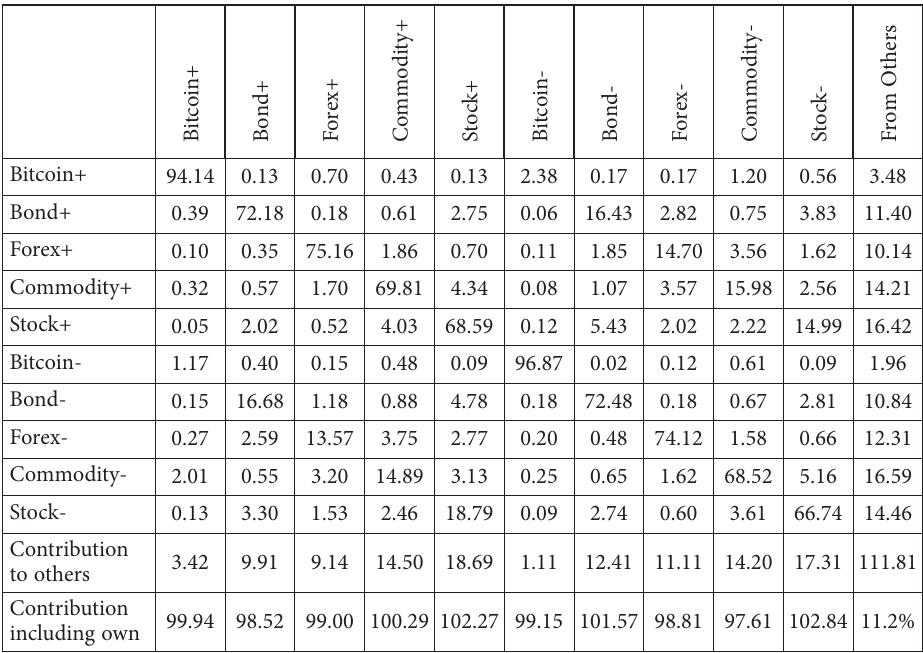
Table 3. Volatility spillover table for the 2N-dimensional VAR model with positive and negative